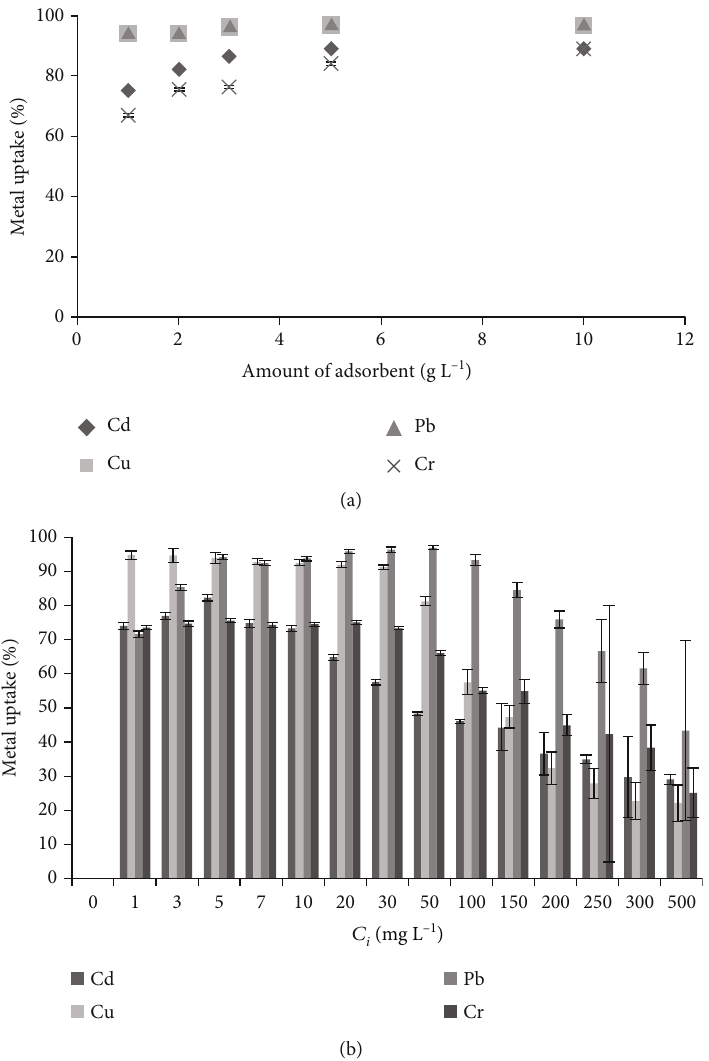
Figure 3: (a) E ff ect of the adsorbent concentration on the metal uptake percentage of Pb(II), Cu(II), Cd(II), and Cr(VI) ( pH = 2 ), C mgL − 1 , pH 5 : 4 , and t = 2 h ( n = 3 ). (b) E ff ect of the initial metal concentration on the metal uptake percentage of Cd(II), Cu(II), Pb(II), and Cr(VI) ( pH = 2 ), adsorbent concentration = 2g L − 1 , t = 2 h, and pH = 5 : 4 ( n = 3